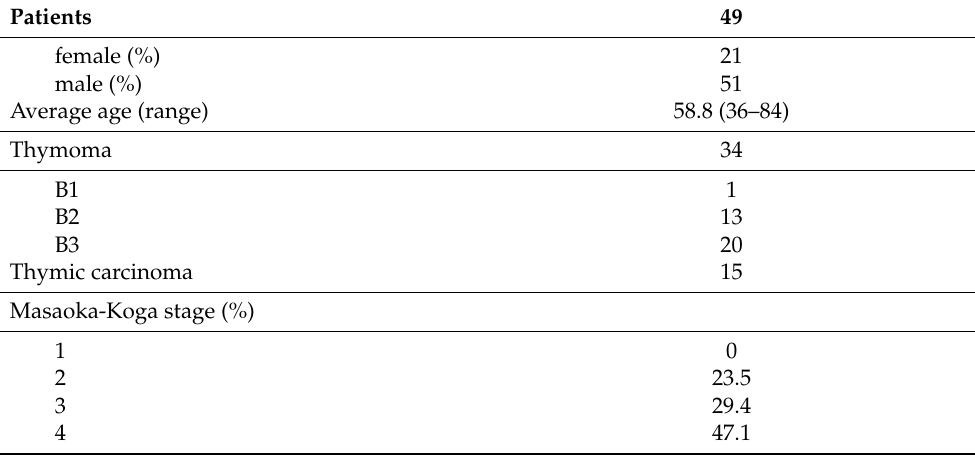
Table 1. Clinicopathological parameters of TET